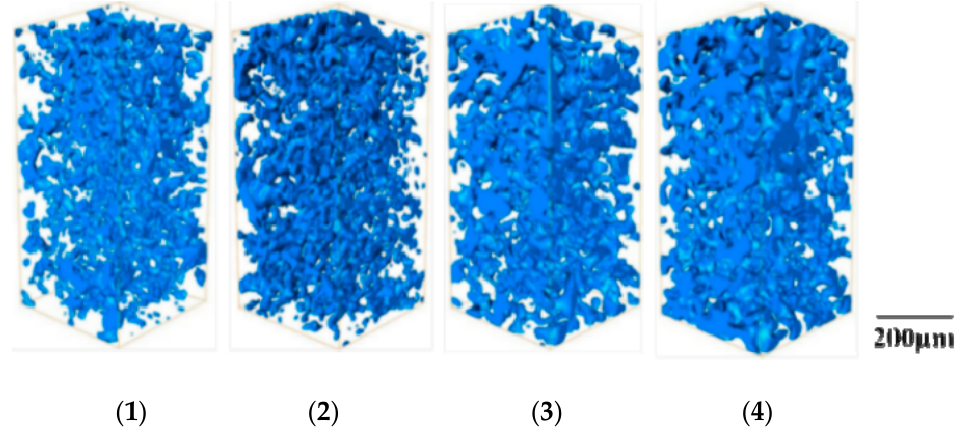
Figure 14. Fine + view pore structure at different heights within the shear-free sample (0.5 mm thick pore distribution). ( 1 ) 2 cm high; ( 2 ) 4 cm high; ( 3 ) 6 cm high; ( 4 ) 8 cm high.